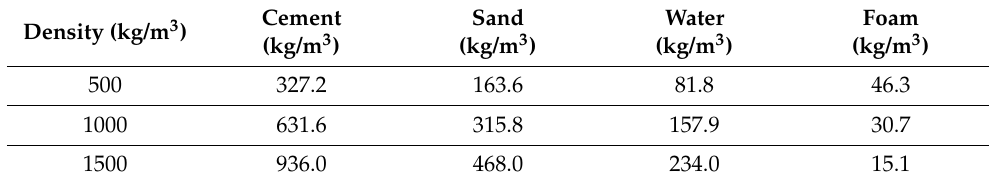
Table 1. Mixture proportions of LFC.